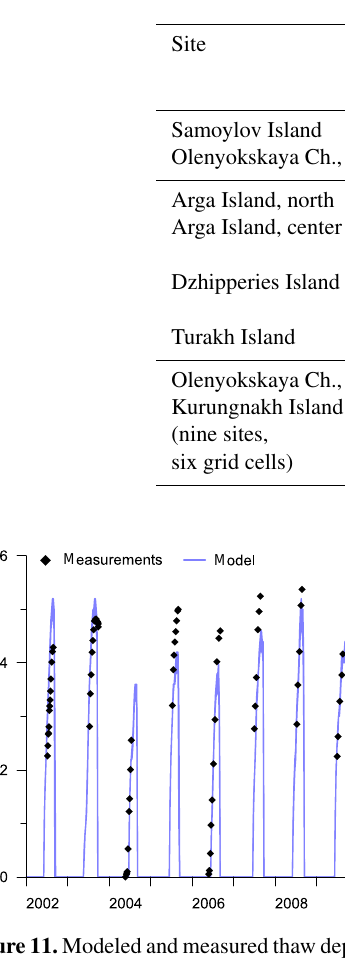
Table 2. Modeled and measured thaw depths in the LRD for confining snow depths of 200 and 250kgm − 3 .